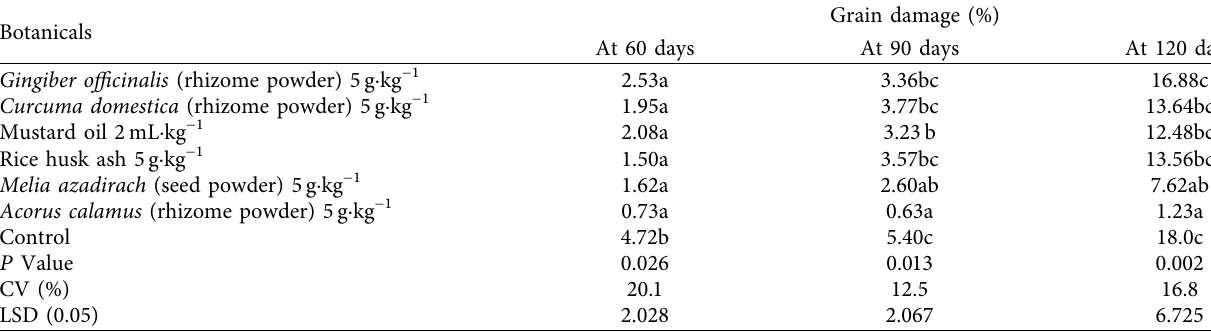
Table 3: Efect of diferent botanicals on grain damage by maize weevil ( Sitophilus zeamais Motsch.) in maize seeds. Botanicals